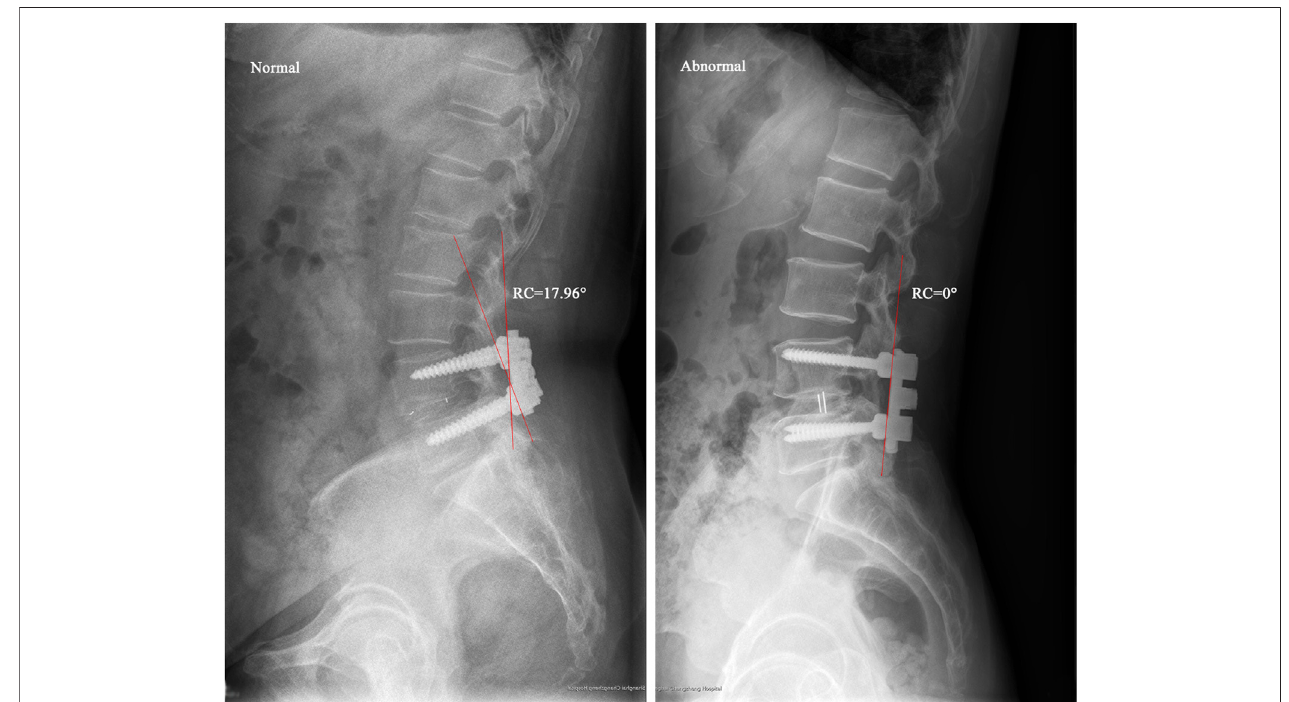
FIGURE 8 | Typical cases showing rod contouring differences between normal and abnormal groups.